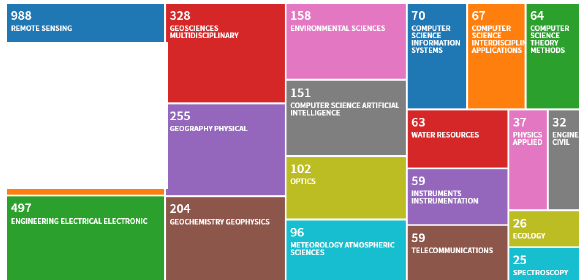
Figure 5. Disciplines of results for query: All = ( benchmark * and ( photogrammetry or remote sensing )) in the Web of Science database.